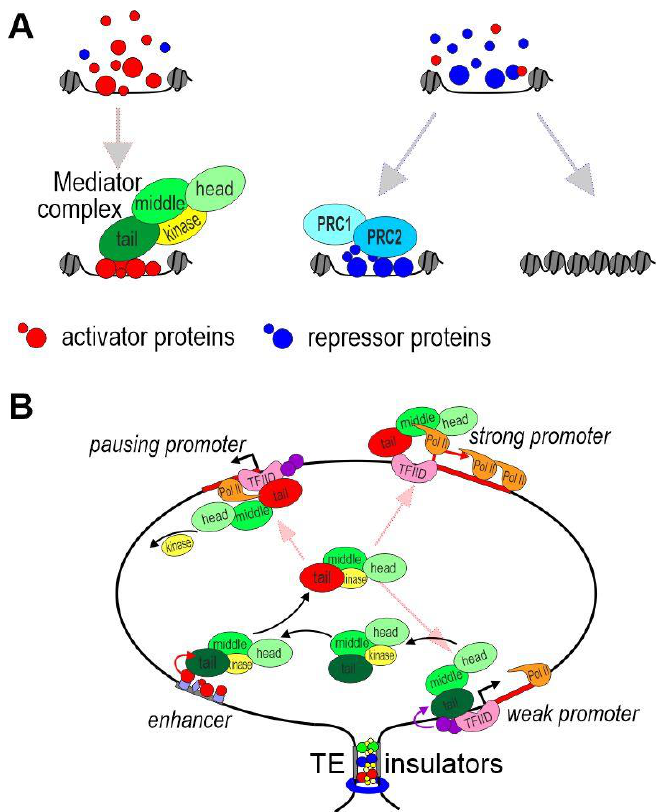
Figure 2. Model of promoter activation by an enhancer. ( A ) Activation or suppression of enhancers. The concentration of activators and repressors determines the fate of the enhancer in a particular nucleus. The mediator complex is recruited to the active enhancer. TFs can still bind to a repressed enhancer. In this case, Polycomb proteins play an important role in the suppression of enhancer activity. Alternatively, compaction of chromatin leads to dissociation of TFs from the enhancer. ( B ) Possible mechanism of functional interaction between an enhancer and promoters at a distance. Tethering elements or insulators form a chromatin loop that brings promoters into the active zone of the enhancer. The mediator complexes bind to the promoters located in the area of the enhancer. The level of transcription depends on the properties of a particular promoter.